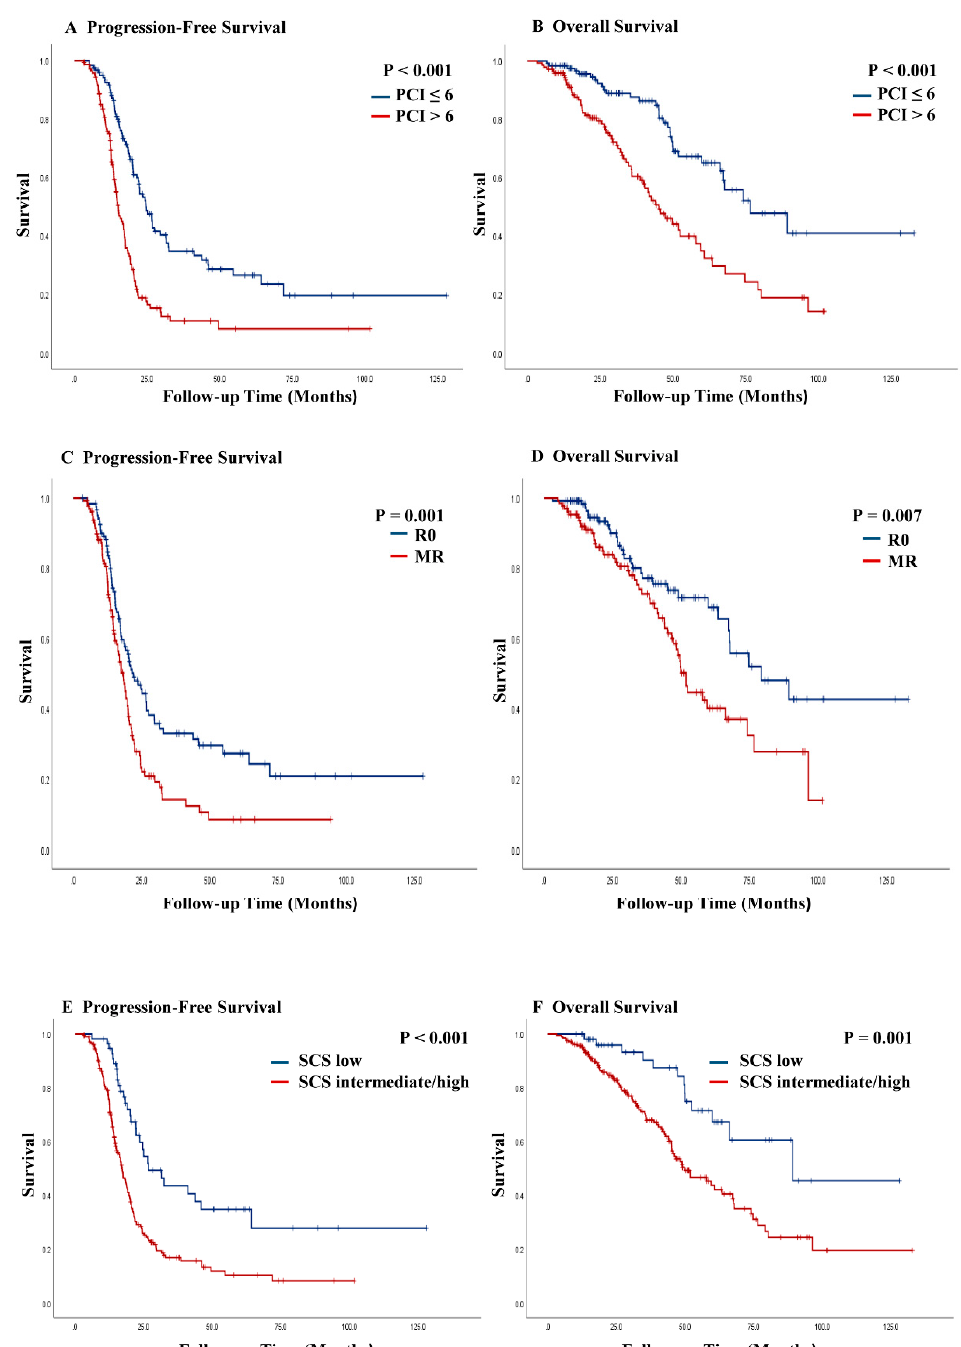
Figure 2. Kaplan–Meier curves of progression-free survival and overall survival stratified by disease burden after neoadjuvant chemotherapy ( A , B ), residual disease ( C , D ), and surgical complexity score ( E , F ). PCI, peritoneal cancer index; R0, no residual disease; MR, <1 cm of residual disease; SCS, surgical complexity